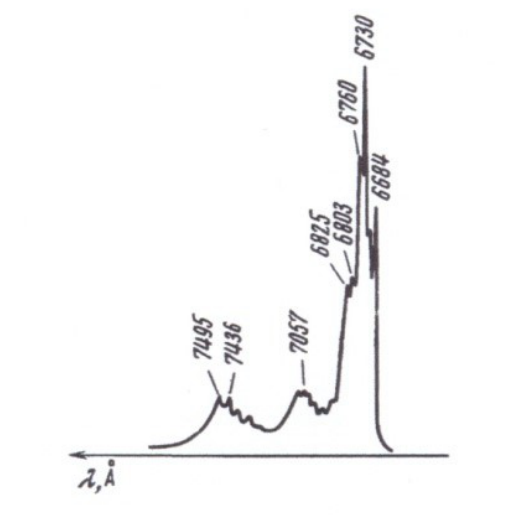
Figure 5. Fluorescence spectrum of Zn-phthalocyanine in parafin oil at 4.2 K. (Personov et al. 1974).